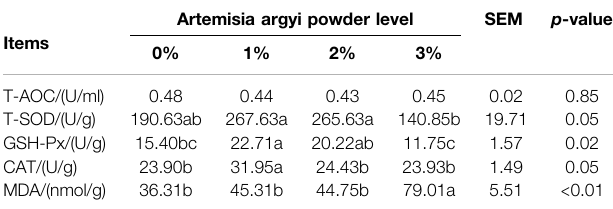
TABLE 6 | Effects of Artemisia argyi on liver Antioxidant Indices of Roman Laying